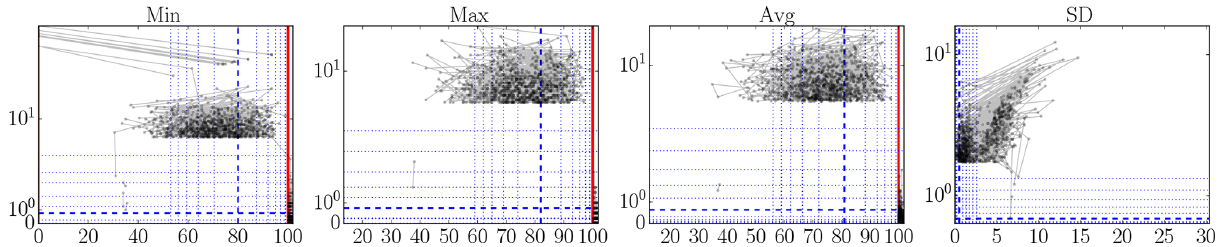
Figure 4. Illustrative plots for visually identifying outliers (see text for an explanation): MMIJ 21m relative humidity data (%).